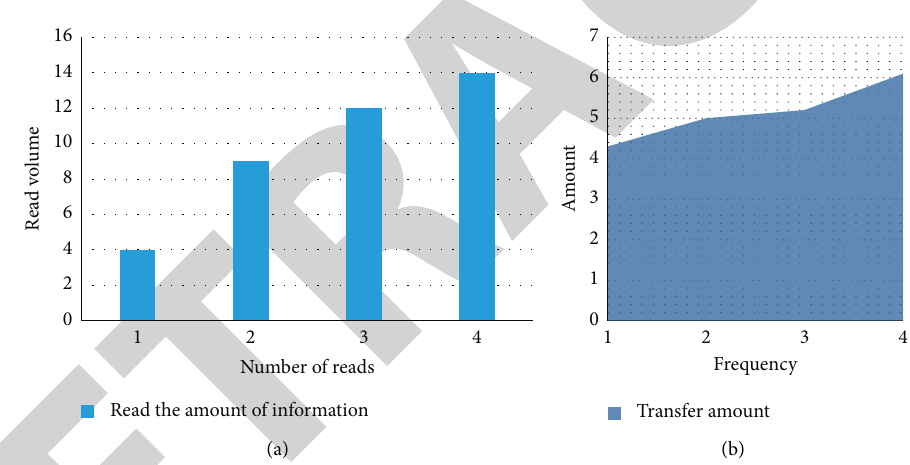
Figure 3: The relationship between the length of system A password and account